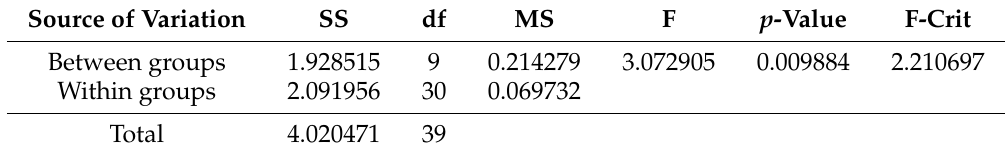
Table 4. ANOVA results for accuracy rate of network attack